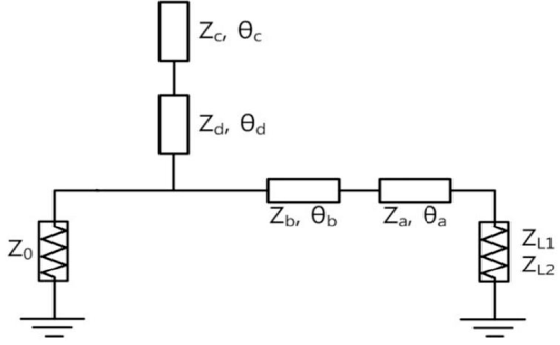
Figure 10. Dual-band matching structure used in [19].